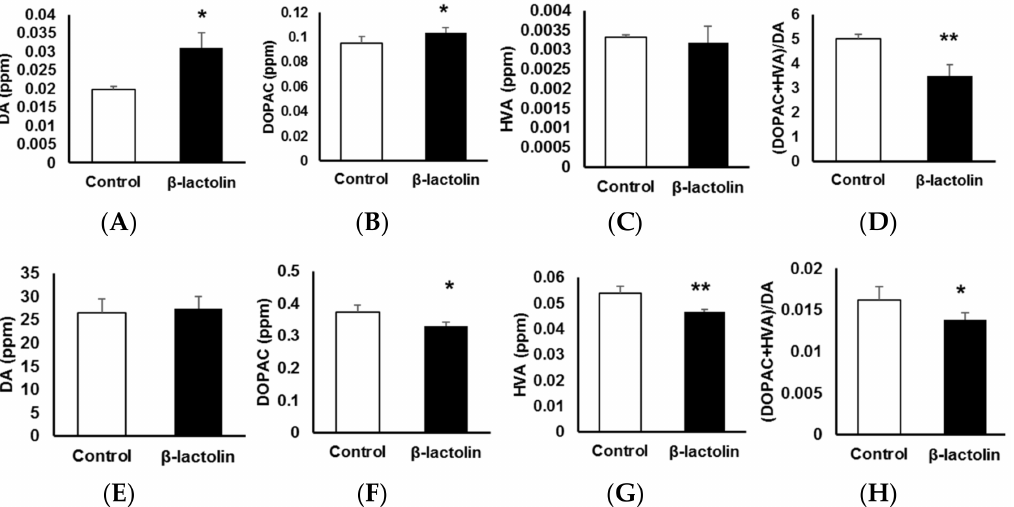
Figure 3. The effects of β -lactolin on dopamine (DA) metabolism in astrocytes. Cells were treated with 0 or 10 µ M β -lactolin for 3 h, following treatment with DA for 2 h. The following monoamine levels in the cells ( A – D ) and in culture media ( E – H ) were measured using high-performance liquid chromatography (HPLC): DA ( A , E ), 3,4-dihydroxyphenylacetic acid (DOPAC) ( B , F ), and homovanillic acid (HVA) ( C , G ). The (DOPAC + HVA)/DA ratio ( D , H ) was also determined. Data represent the mean ± SEM ( n = 6). The p values were calculated using the Student’s t -test. * p < 0.05, ** p < 0.01. DA, dopamine; HPLC, high-performance liquid chromatography; DOPAC, 3,4-dihydroxyphenylacetic acid; HVA, homovanillic acid; SEM, standard error of the